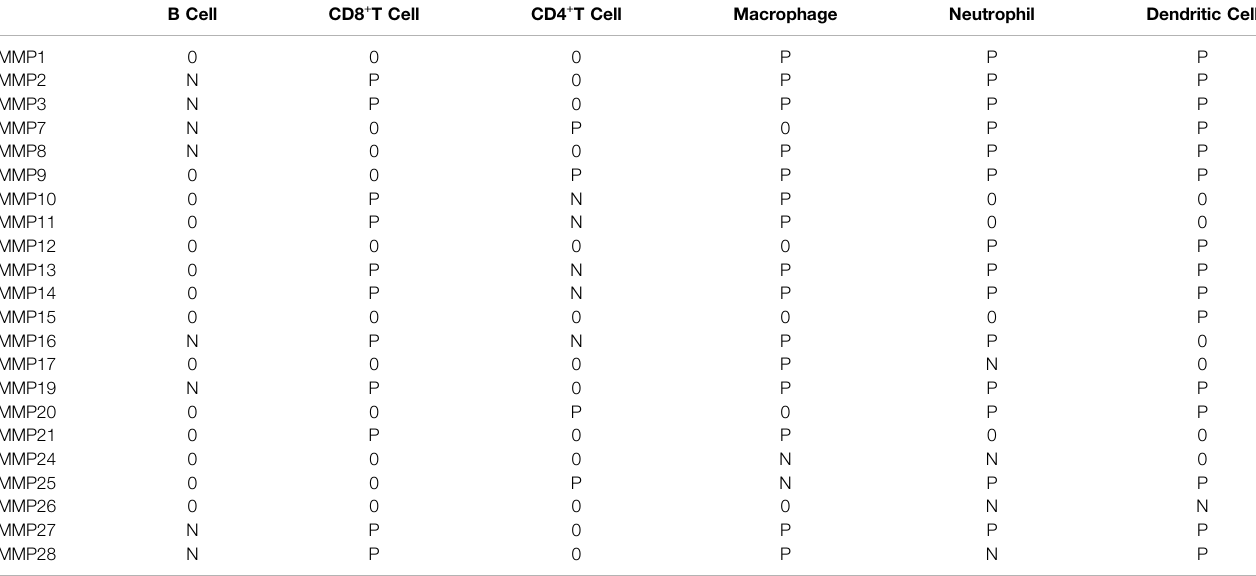
TABLE2| CorrelationsbetweenMMPsexpressionandimmunecellin fi